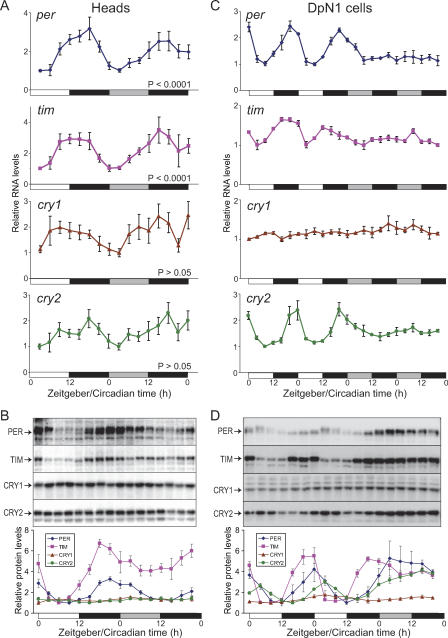
Temporal Patterns of Clock Gene RNA and Protein Expression in Monarch Heads and DpN1 Cells(A) Temporal profiles of clock gene RNA expression in heads. Heads were collected at 3-h intervals for 24 h in LD and during the first day in DD. RNA levels were quantitated by qPCR. Each value is the mean ± SEM from 6 sets of heads. Open bars, light; black bars, dark; gray bars, subjective day. p-value determined by one-way ANOVA.(B) Temporal profiles of clock proteins in heads. Heads were collected at 3-h intervals for 24 h in LD and during the first day in DD. Extracts were prepared, analyzed by Western blot and probed for PER (GP40), TIM (GP47), CRY1 (GP37), and CRY2 (GP51). Blots were imaged by chemiluminescence, and band intensity was quantified. The results were normalized against α-tubulin. Each value is the mean ± SEM from six heads. In LD: PER and TIM, p < 0.001. In DD: PER, p < 0.01; TIM, p > 0.05.(C) Temporal profiles of clock gene RNA expression in DpN1 cells. Cells were collected at 4-h intervals for two days in LD followed by two days in DD, and RNA levels were quantitated by qPCR . Each value is the mean ± SEM of three collections.(D) Temporal profiles of clock proteins in DpN1 cells. Cell homogenates were prepared, analyzed by Western blot and probed for PER (GP40), TIM (GP47), CRY1 (GP37), and CRY2 (GP51). Blots were imaged by chemiluminescence, and the band intensity was quantified. The results were normalized against α-tubulin. Each value is the mean ± SEM of three collections. In LD, PER, p < 0.05; for TIM and CRY2, p < 0.001.